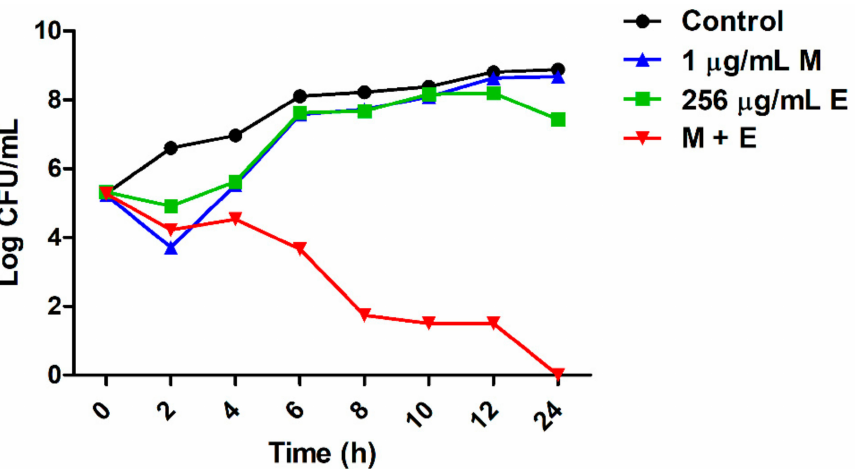
Figure 1. Synergistic effect of equol and meropenem against carbapenem-resistant E. coli . E. coli KBN12P05816 strain treated with equol and meropenem at 37 ◦ C. Each sample was plated with a spreader on MHA and incubated at 37 ◦ C for 24 h. The CFU/mL values were recorded. ( • ) Control; ( (cid:4) ) 256 µ g/mL of equol; ( (cid:78) ) 1 µ g/mL of meropenem; ( (cid:72) ) the combination of 1 µ g/mL of meropenem plus 256 µ g/mL of equol. A sample not treated with equol and meropenem was used as the